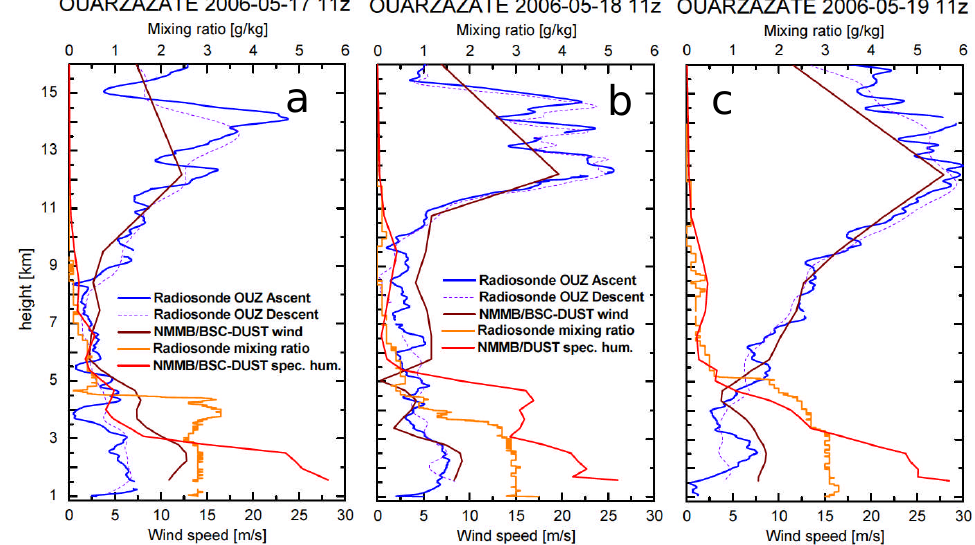
Fig. 12. Vertical profile of wind speed (blue, brown), specific humidity (red), and mixing ratio (orange) over Ouarzazate between 17–19 May 2006 is shown (a–c) . Comparison of simulated winds versus that derived from morning radiosonde launch.